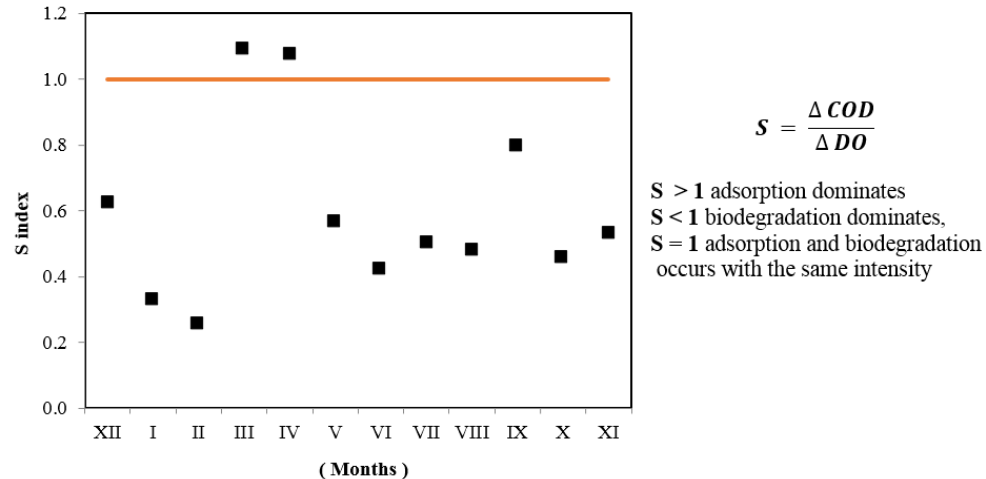
Figure 4. Average monthly changes in S indicator after biofiltration process.